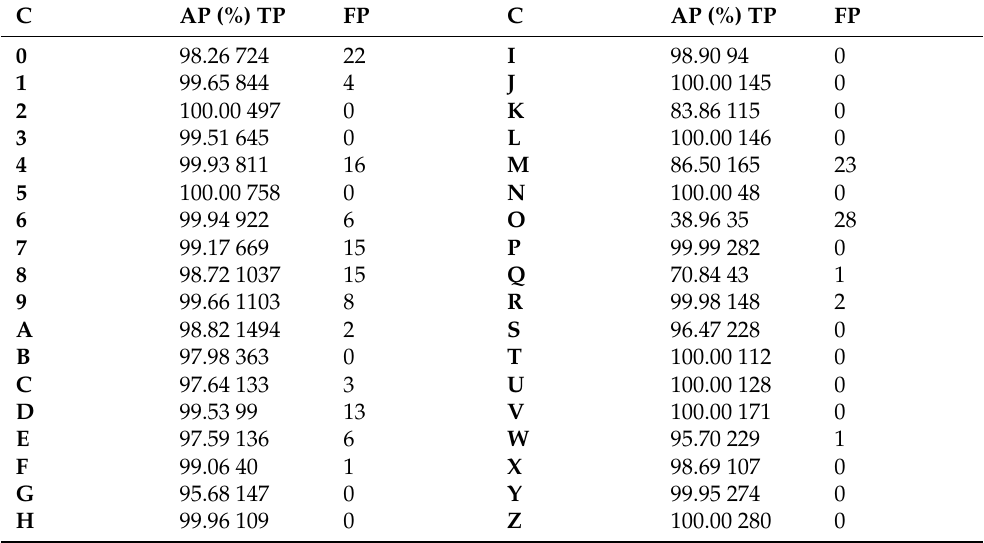
Table 11. All characters’ average precision (AP) across all datasets in the test sets